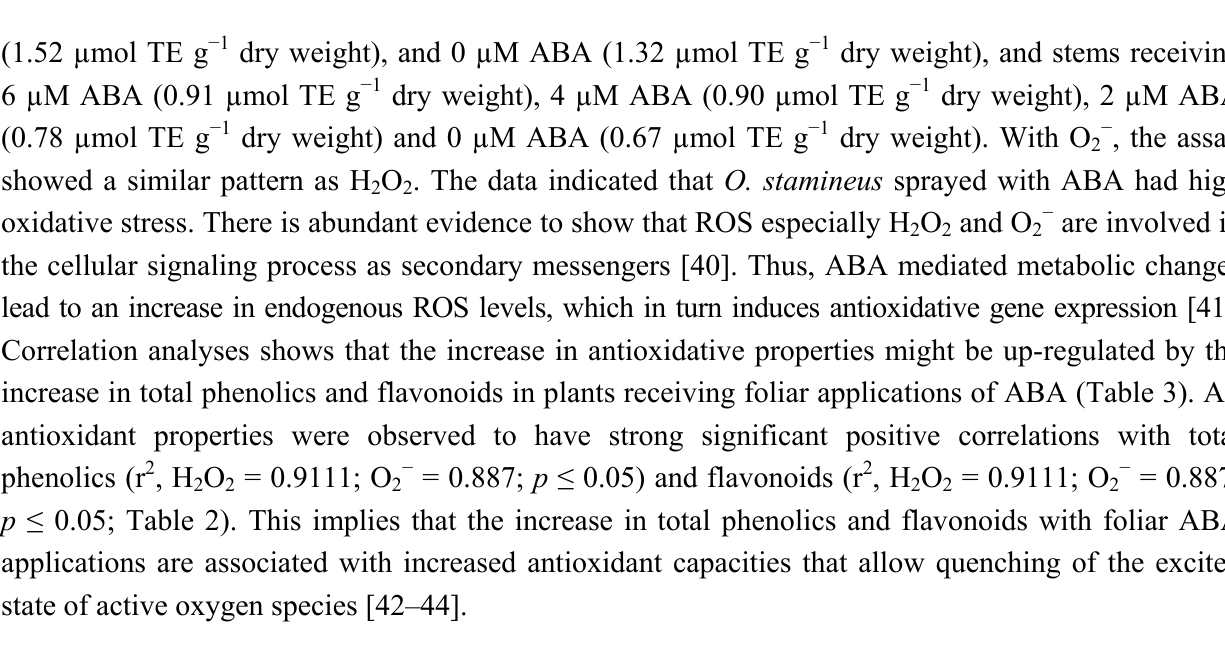
− and PAL activity in different parts of O O 2 2, 2